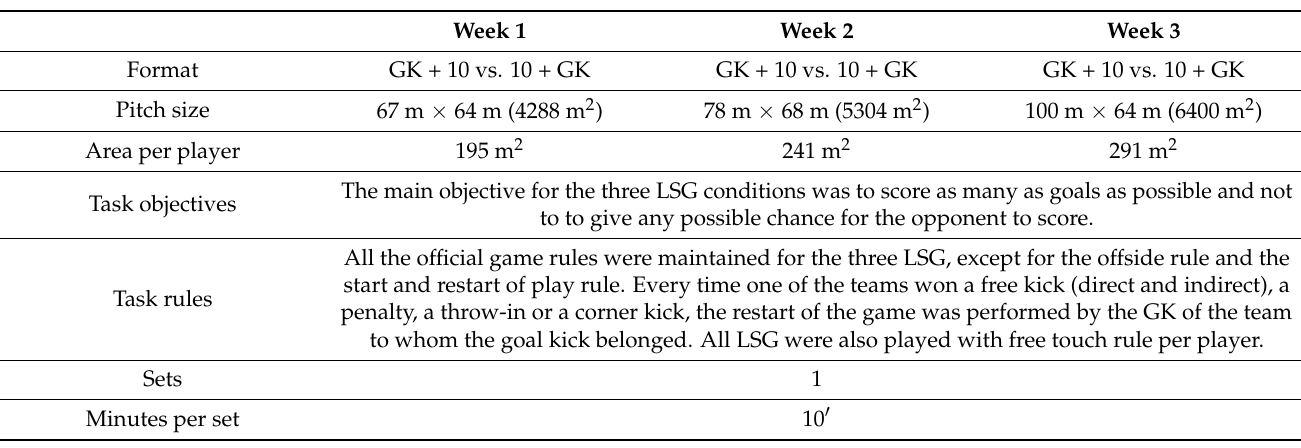
Table 2. Large-sided games